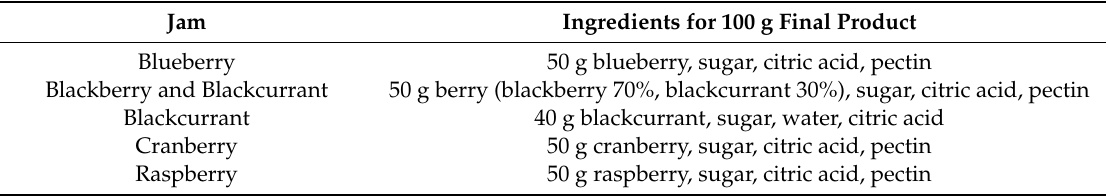
Table 1. Ingredients listed on the label of each berry jam used in this